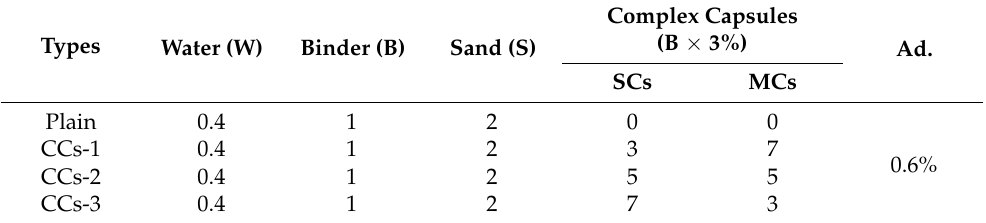
Table 2. Mixing ratio of the mortar.